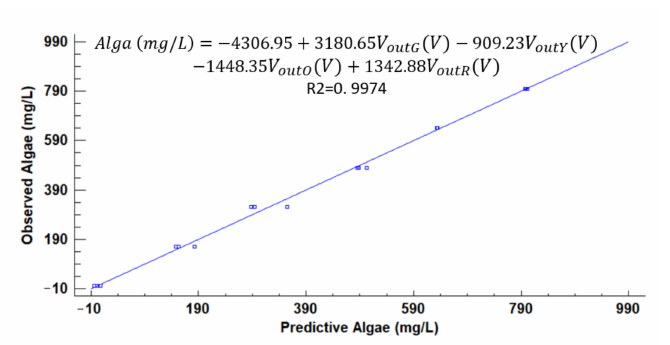
Figure 16. Observed vs. predicted values of algae concentration with a solid concentration of 800 mg/L.